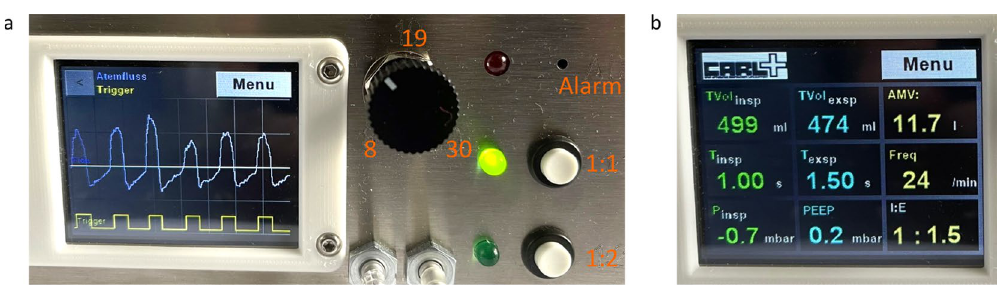
Figure 7. Photo of the user interface of CARL. ( a ) Entire interface with a display of a flow curve. Ventilation parameters are highlighted in orange. ( b ) Display of the current ventilation parameters and ventilation